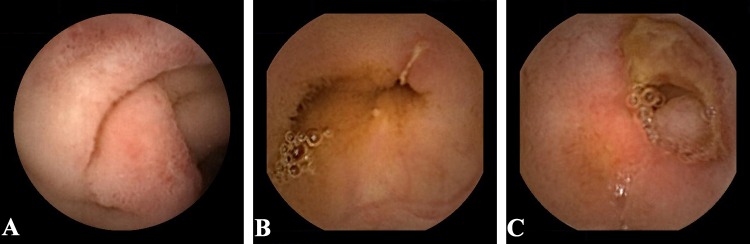
Macroscopic small intestinal mucosal injuries under capsule endoscopy.(A) Villous appearance, defined as edema in which villous width is equal to or greater than villous height. (B) Ulcer, defined as mucosal breaks with white or yellow bases surrounded by red or pink collars. (C) Stenosis.